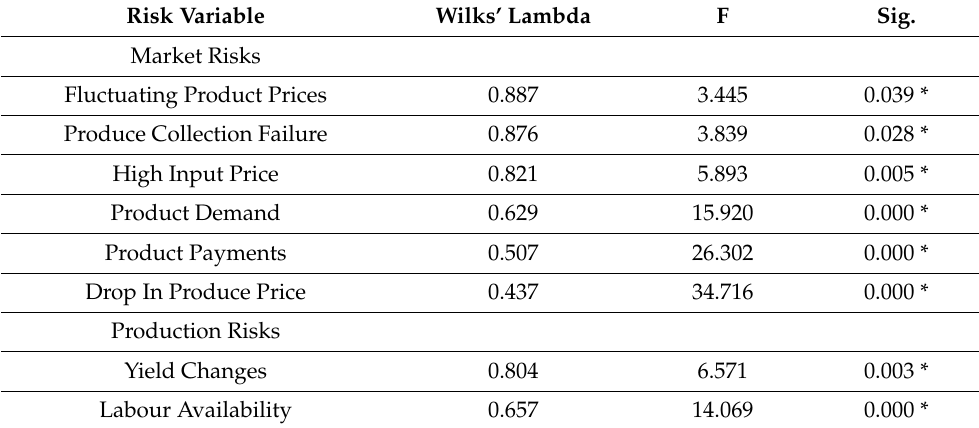
Table 2. The role of predictors in explaining the risk variation.